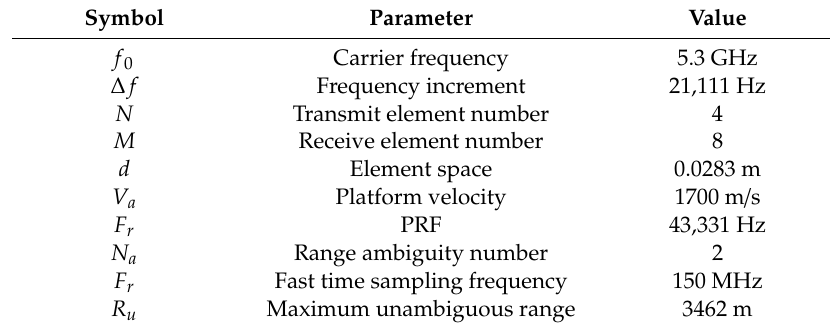
Table 1. Forward-looking FDA system parameters. Note: PRF, pulse repetition frequency.